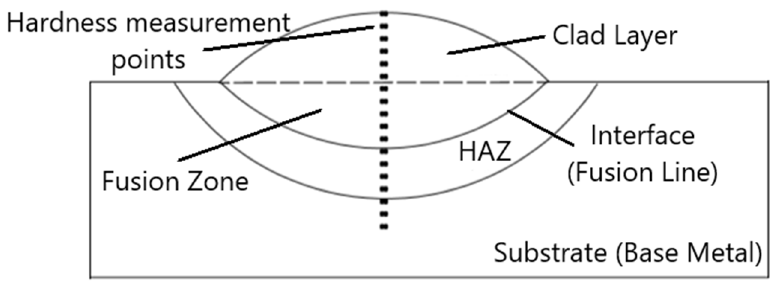
Figure 11. Scheme of hardness measurements on the cross-section of a single stringer bead, Figure 12.